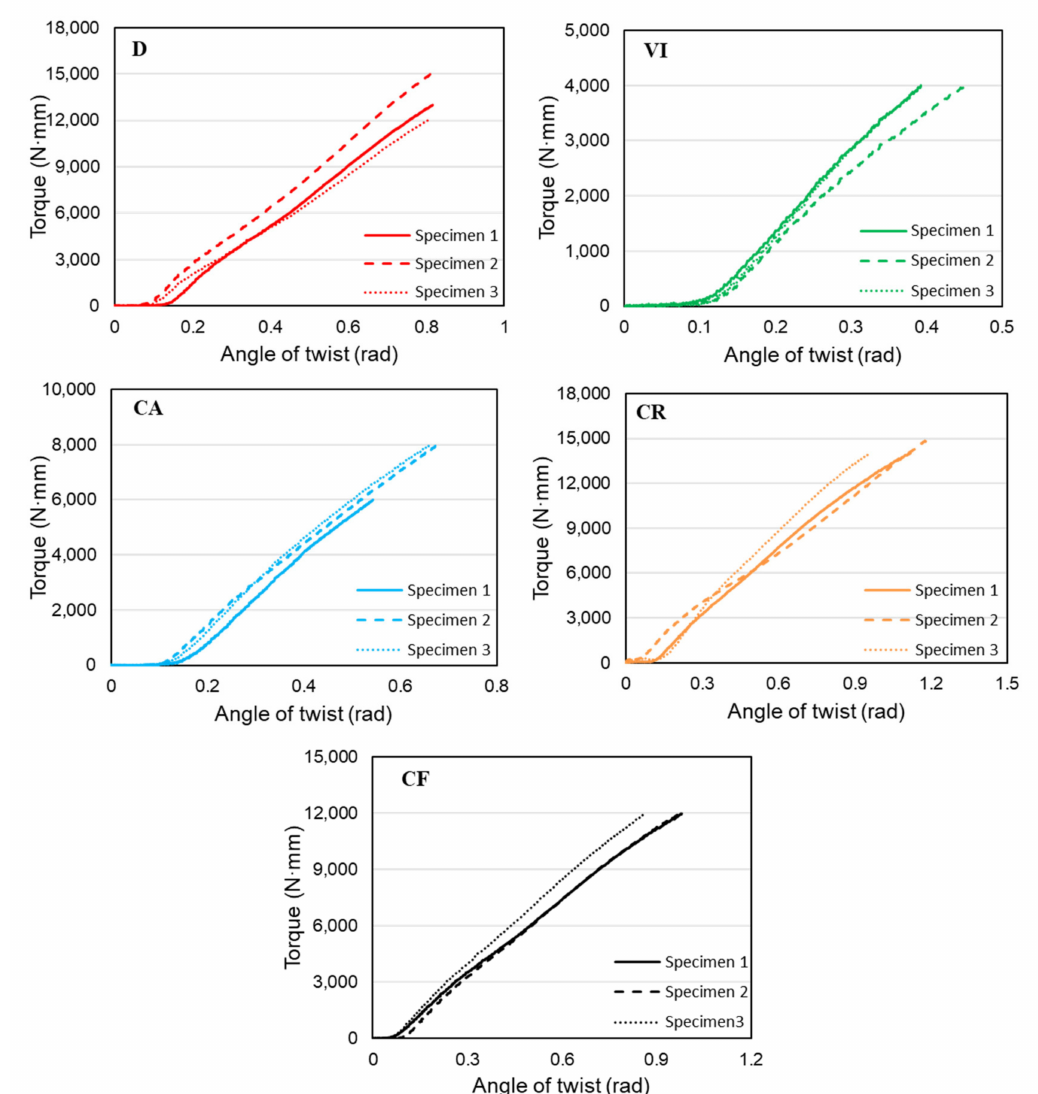
Figure 11. Elastic regions of structures for calculation of torsional stiffness.